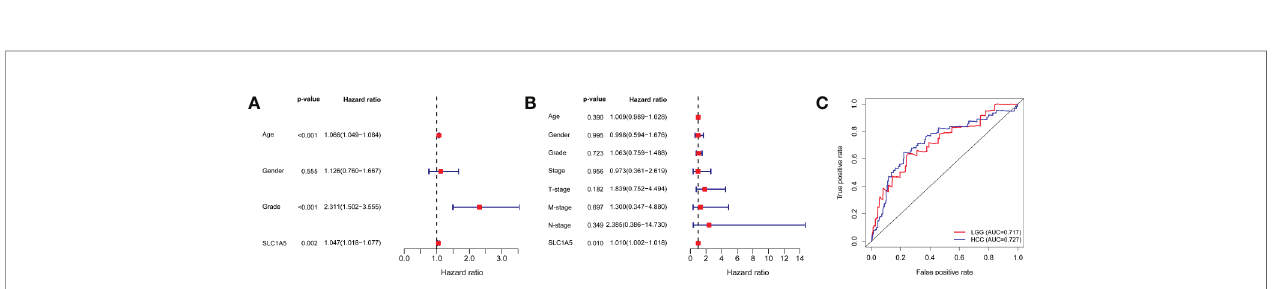
FIGURE 3 | Multivariate Cox analysis of SLC1A5 expression and other clinicopathological variables in LGG (A) and HCC (B) . (C) ROC curve of differential SLC1A5 expression in LGG and HCC. OS = overall survival; LGG, lower-grade glioma; HCC, hepatocellular carcinoma; and ROC, receiver operating